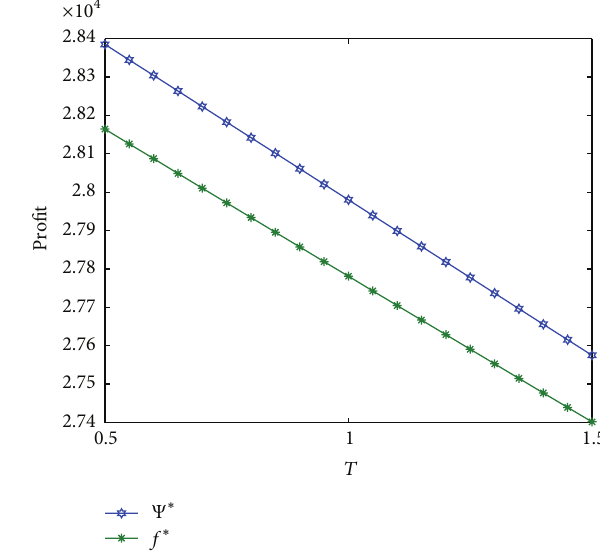
Figure 10: Impacts of 𝛼 on 𝑞 ∗ and 𝑞 ∗ 𝑅 .